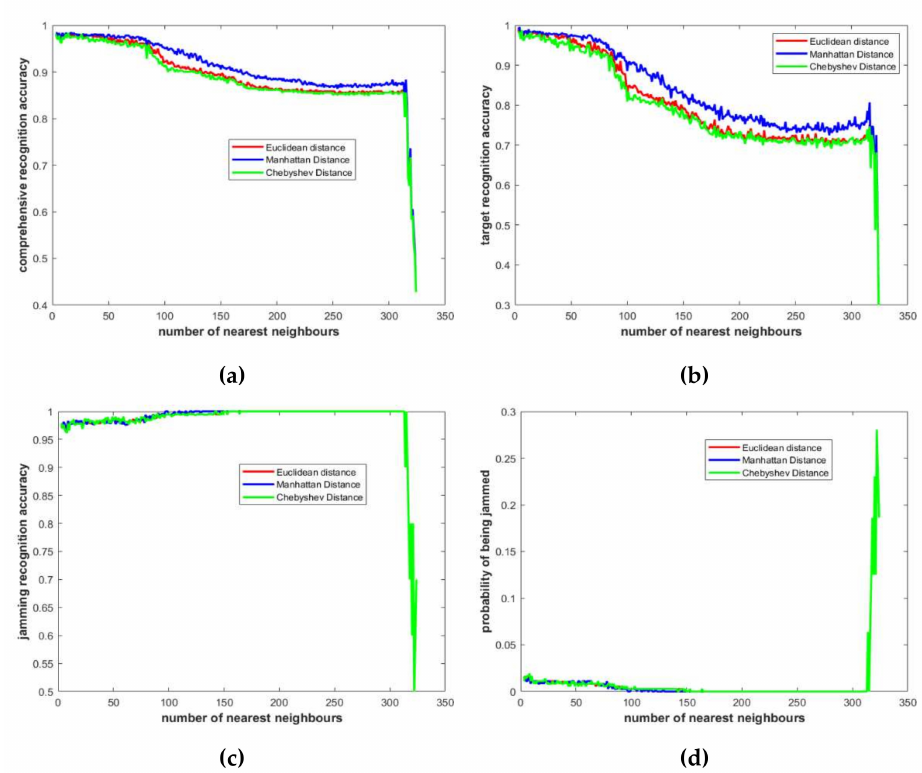
Figure 7. Plot of experiment results. ( a ) comprehensive recognition accuracy; ( b ) target recognition accuracy; ( c ) jamming recognition accuracy; ( d ) probability of being